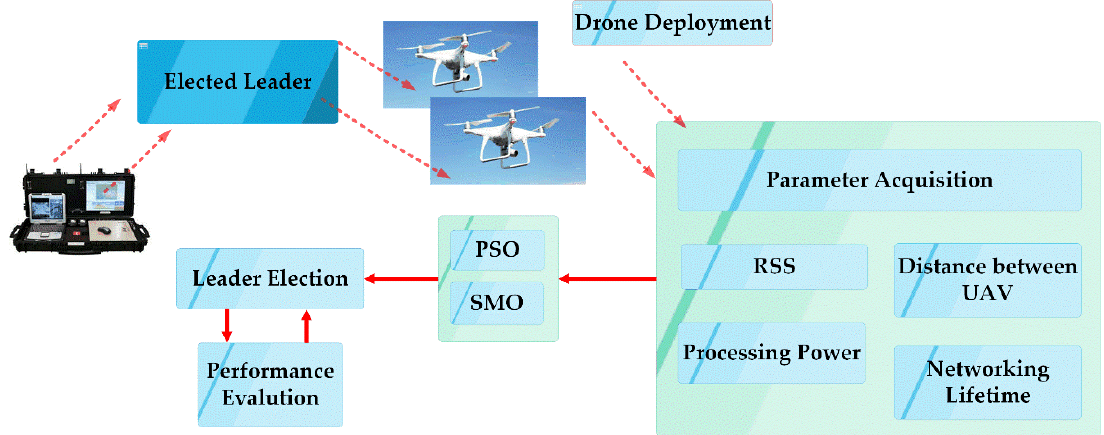
Figure 3. The system architecture of proposed BOLD for multiple drones.